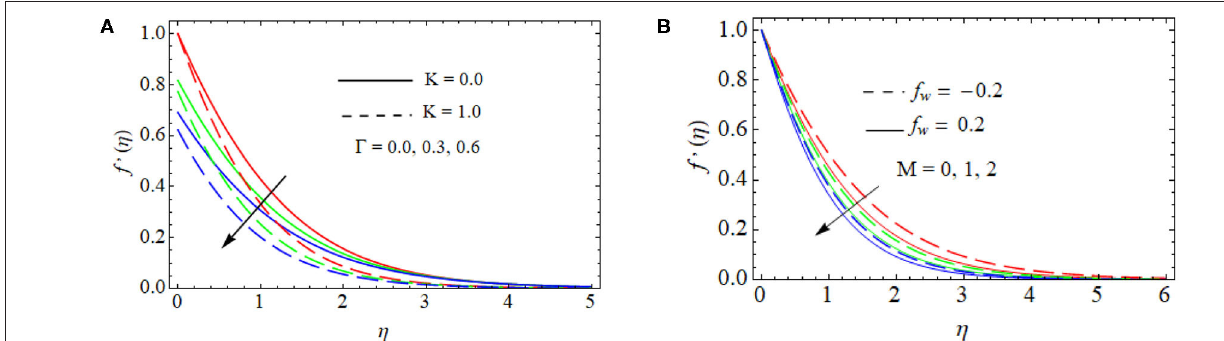
FIGURE 3 | (A,B) Impact of Ŵ and M on velocity profile f ′ (η) .